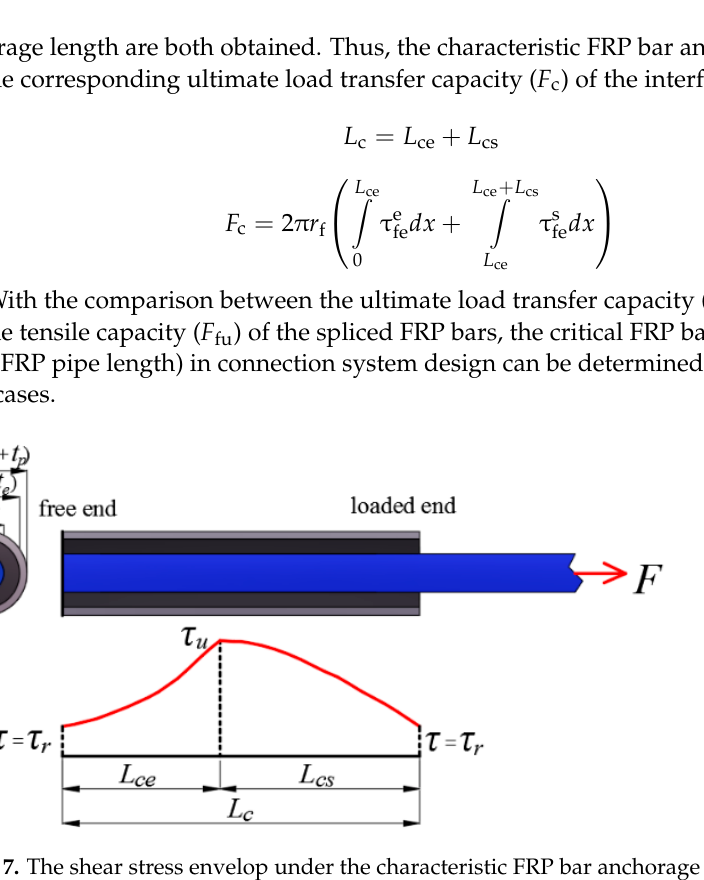
Figure 7. The shear stress envelop under the characteristic FRP bar anchorage length.